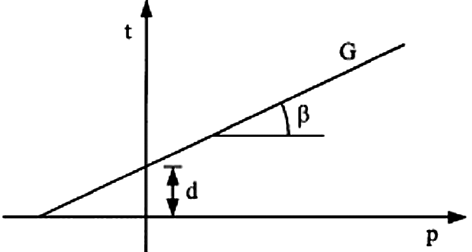
Fig. 4. Linear Drucker (cid:1) Prager yield criterion for